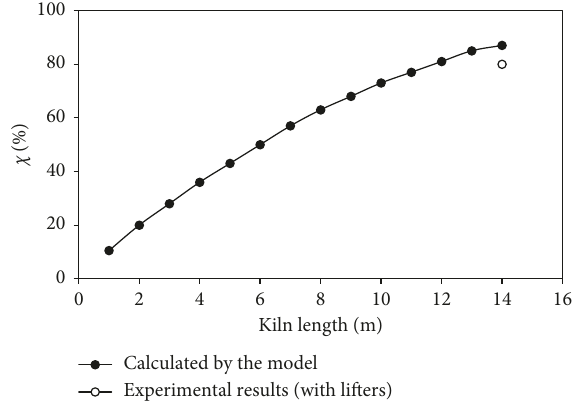
Figure 7: Comparison between experimental conversion in the rotary kiln ( χ ) with lifters and conversion calculated with the Not Reacted Core model ( d 80 2.9